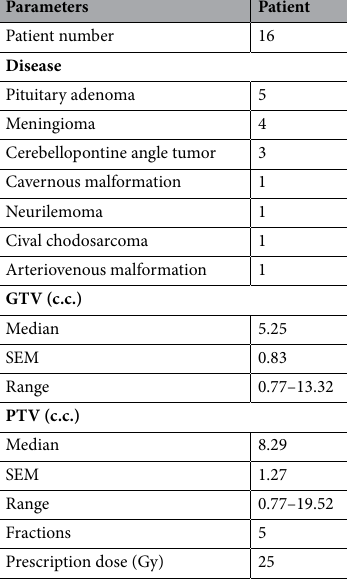
Table 1. Characteristics of benign brain lesion patients. CTV clinical target volume, PTV planning target